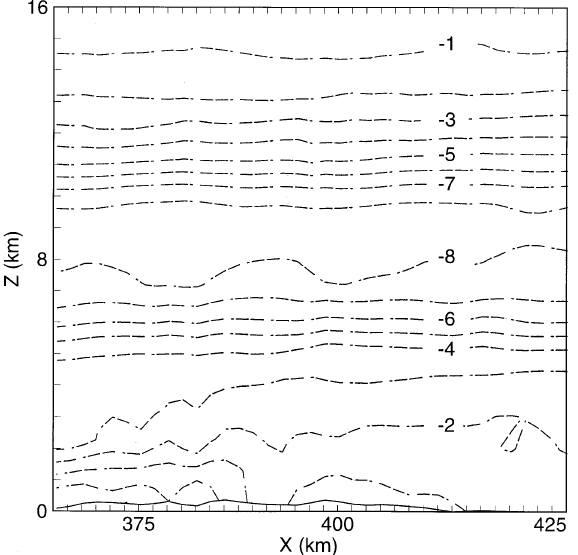
Fig. 8. xz cross section of the horizontal wind component u (cid:120) for the inner model domain at 415 km North (NGR) at 120 min. The contours are given in m/s in 1 m/s intervals. The surface topography is outlined